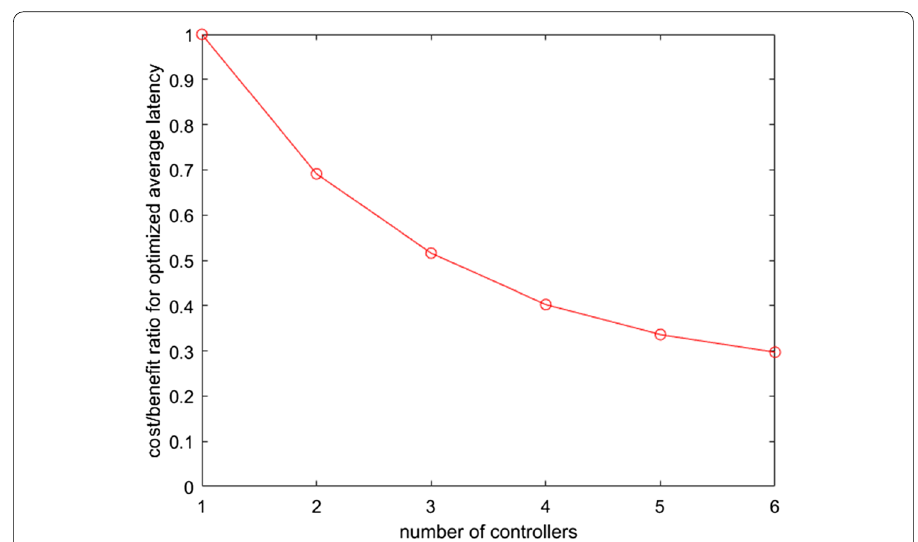
Fig. 7 Cost–benefit ratios diagram, higher is better. x axis: number of controllers. y axis: Cost–benefit ratios for optimized average latency. We define a benefit–cost ratio to represent the cost of building the network. This value can reflect the proportional relationship between the communication delay with different number of controllers and the communication delay with one controller. By judging the rake ratio of the numerical value, we can choose the optimal number of controllers so that we can get higher